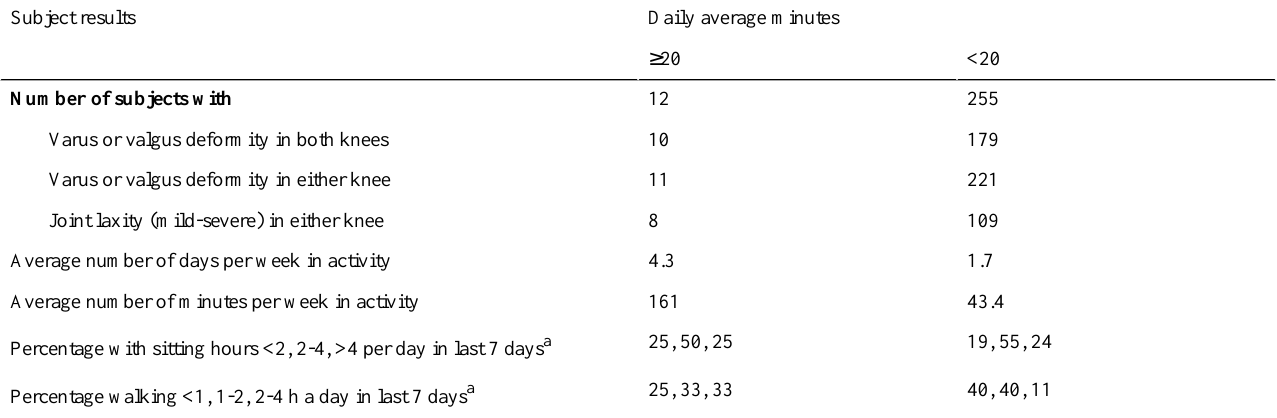
Table 3. Knee deformity and PASE results of subjects with at least one instance of the pattern class [3501-4200) X